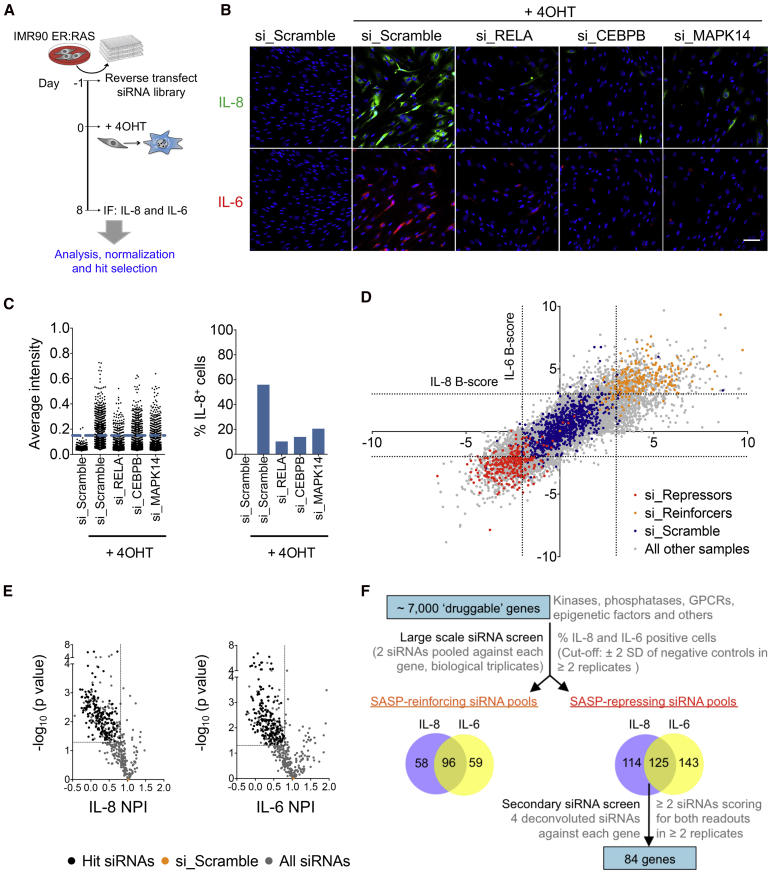
An siRNA Screen Identifies Regulators of the SASP(A) Workflow of the SASP siRNA screen.(B) Representative immunofluorescence (IF) images of IL-8 and IL-6 following transfection of indicated siRNAs. Scale bar, 100 μm.(C) IF quantification. Left panel shows single-cell intensity values of IL-8 in a representative sample well of a 96-well plate seeded with cells transfected with indicated siRNAs. Blue line denotes quantification cutoff resulting in the IL-8 percentages shown in the right panel.(D) Screen results. Normalized IL-8 versus normalized IL-6 values for each replicate sample of the screen. Dotted lines indicate cutoffs of ±2 SD of negative scramble controls. siRNA pools were considered “hits” if they showed a B score of >−2 or <3, in at least 2 out of 3 replicates for both IL-6 and IL-8.(E) Volcano plots of the secondary siRNA screen performed in IMR90 ER:RAS cells as per the workflow given in (A). Normalized percent inhibition (NPI) shown as mean of 3 replicates. Three replicate NPI values of each sample siRNA were compared with all scramble siRNA values by unpaired Student's t test. Eighty-four genes met the selection criteria depicted by lines: ≥2 siRNAs with an IL-8 and IL-6 NPI <0.8 and a p value of ≤0.05. Only siRNAs targeting the 84 genes are color coded as “Hit siRNAs”.(F) Summary of SASP screen. Venn diagrams (not to scale) show number of siRNA pools passing the filter and overlap between IL-8 and IL-6.See also Figure S1.